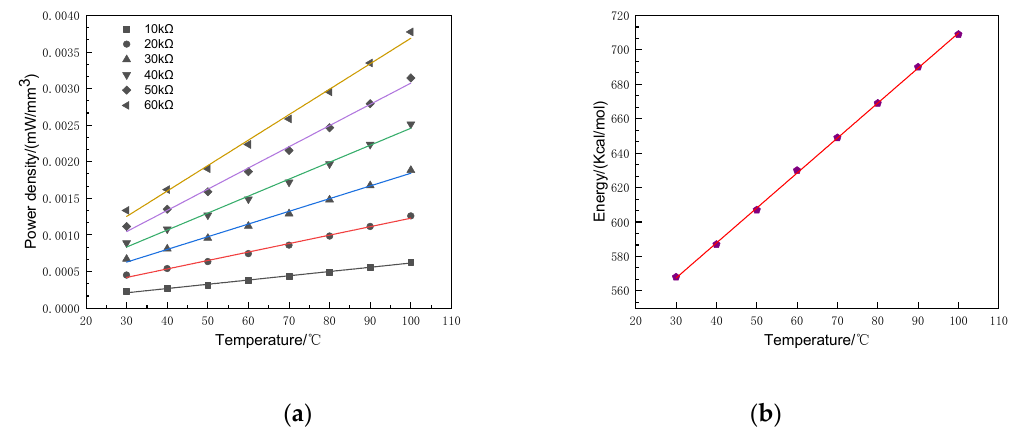
Figure 11. Power density and energy analysis. ( a ) Power density; ( b ) Atomic energy.